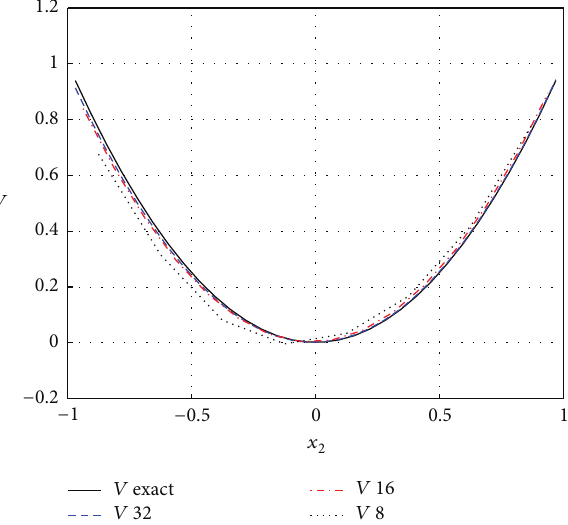
Figure 4: Value cost function for Example 2 via the SHWCM with = −0.1250, −0.0625, −0.0313 , 𝑚 = 8,16, 32 and 𝑥 1